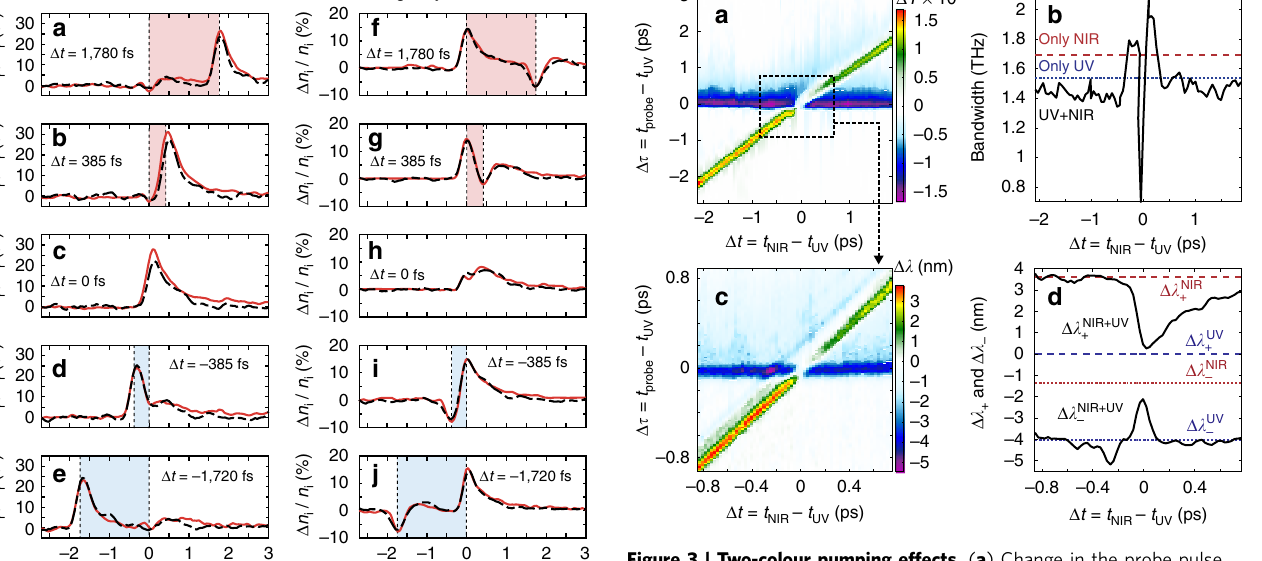
Figure 3 | Two-colour pumping effects. ( a ) Change in the probe pulse transmission as a function of the pump–probe delay ( D t ) and the inter- pump delay ( D t ). The ultraviolet (UV) pump decreases the transmission, whereas the NIR increases it. The combined effect produces a D t-dependent modulation. The modulation bandwidth is evaluated by performing a Fourier transform along D t , and is shown by the black curve in b . For delays close to D t ¼ 0, the modulation bandwidth can be decreased or increased by the two-colour combined effect. The blue and red dashed lines show the bandwidth of the ultraviolet-only and NIR-only driven modulation. ( c ) Measured central wavelength shift of the transmitted probe pulse ( C 15nm bandwidth) in a zoomed D t (cid:2) D t region (square box in a ). The ultraviolet pump blue shifts the probe wavelength, whereas the NIR pump does the opposite. At D t C 0, the opposite effects almost entirely cancel the wavelength shift. ( d ) Summary of the findings in c , showing the maximum positive ( D l þ ) and negative ( D l (cid:2) ) wavelength shift for the NIR-only (red dashed/dotted), ultraviolet-only (blue dashed/dotted) and two-colour (solid black) AZO excitation.